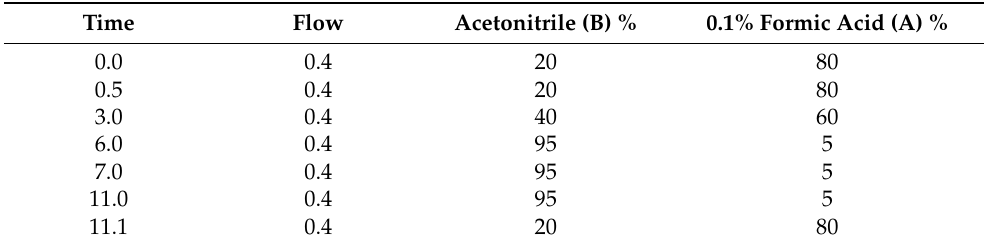
Table 2. Chromatographic conditions for detection of 11 mycotoxins by AB SCIEX QTRAP ® 6500+ LC-MS/MS.